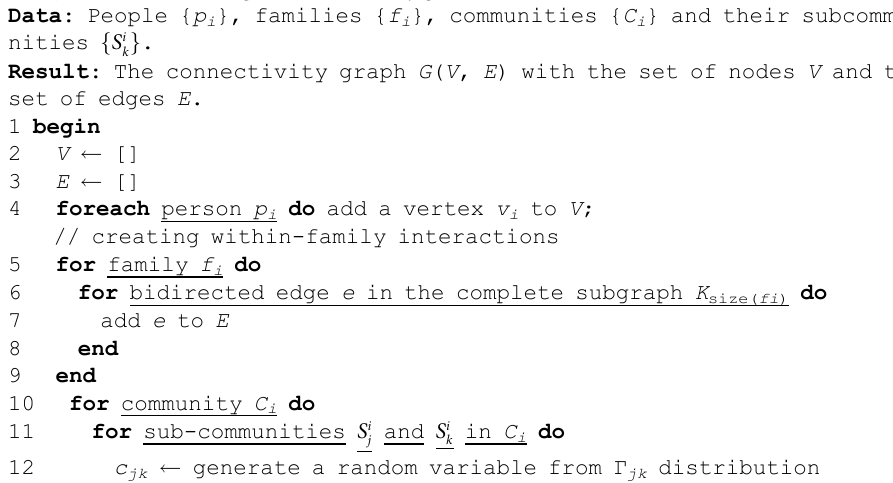
Algorithm 2 : Creating the connectivity